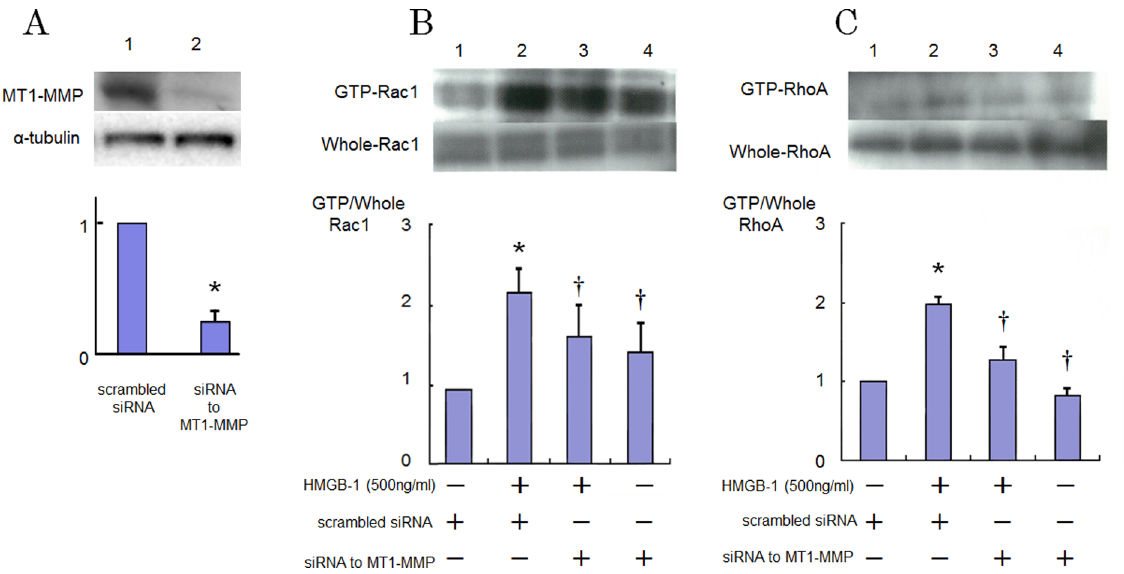
Fig. 5. Effects of inhibition of MT1-MMP with siRNA on increased GTP-loading of RhoA and Rac1 caused by HMGB-1 in HAECs. (A) Effect of knockdown of MT1-MMP by siRNA on the MT1-MMP protein level as determined by western blotting. Bars are mean ¡ S.D. of quantitative densitometric analyses from 3 separate experiments. Representative immunoblots from 3 independent experiments are shown. * P , 0.05 vs. Lane 1. (B and C) Cells were incubated in the presence of HMGB-1 with or without transfection with siRNA to MT1-MMP. Bars are mean ¡ S.D. of 4 separate experiments. Representative immunoblots from 4 independent experiments are shown. * P , 0.05 vs Lane 1; { P , 0.05 vs. Lane 2.